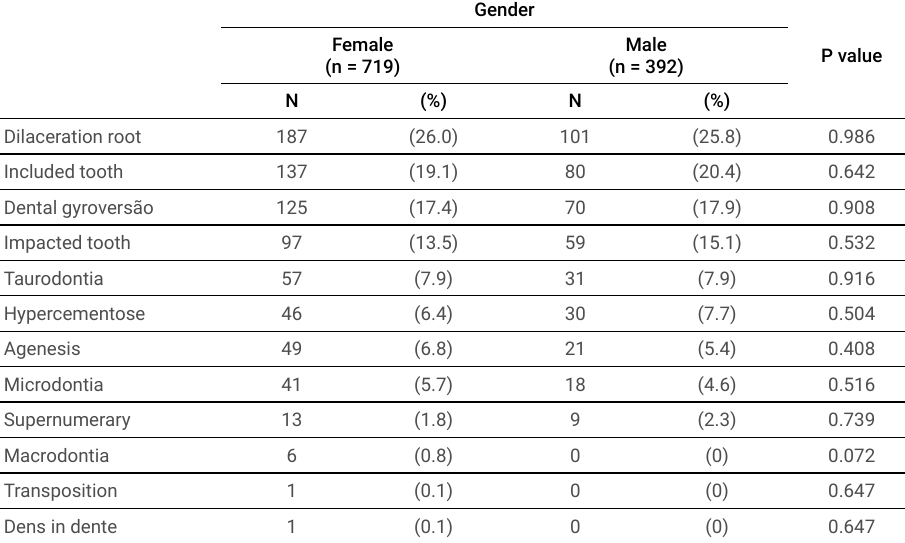
Table 1. Incidental findings prevalence of DDA their predilection for female or male